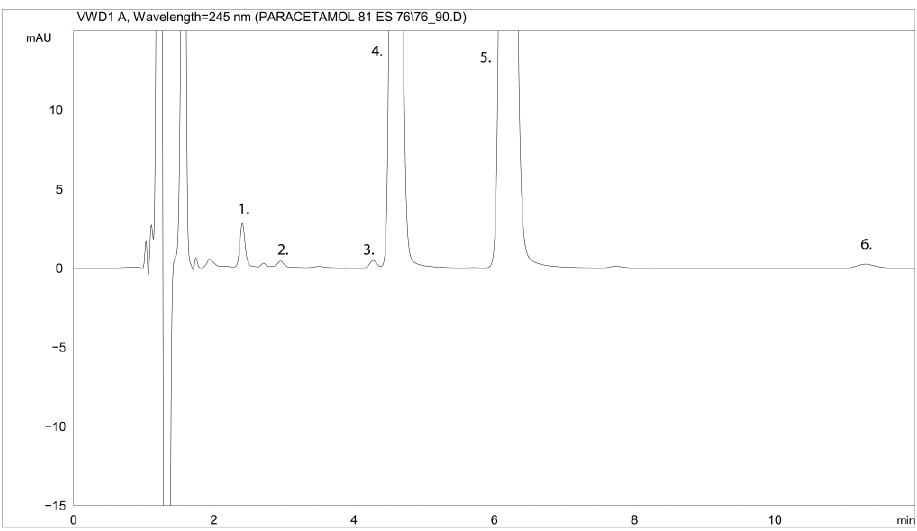
Figure A2. HPLC chromatograms the perfusate generated in rat small intestine luminal after 90 min of perfusion. Peak 1 is paracetamol β -D-glucuronide, peak 2 is paracetamol cysteine, peak 3 is paracetamol sulphate, peak 4 is paracetamol, peak 5 is theophylline (internal standard), and peak 6 is paracetamol mercapturate.